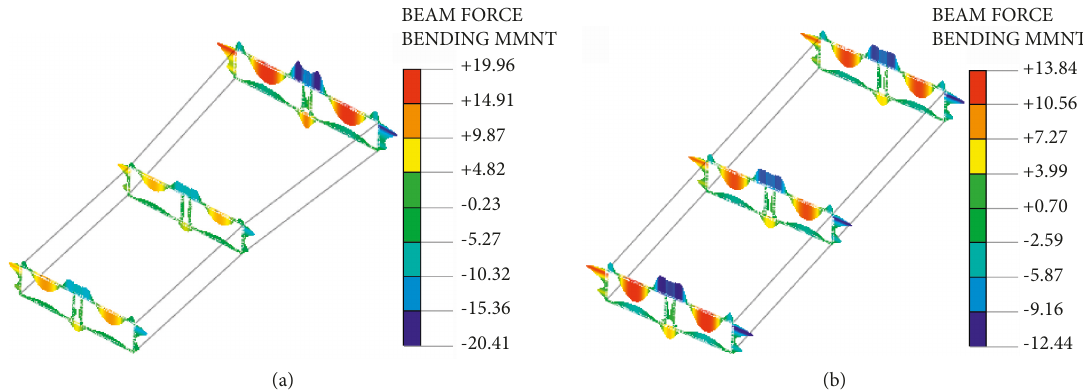
Figure 10: The bending moment nephogram of segment E1 with a (a) variable cross section and (b) uniform cross section ( × 100kN · m).